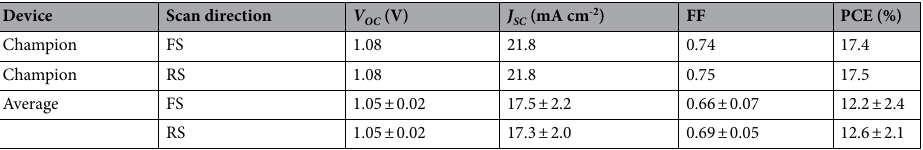
Table 2. Device performance based on slot-die coated perovskite films with the architecture Glass/ITO/poly- TPD/perovskite/PCBM/BCP/Ag. The average data is based on 15 single